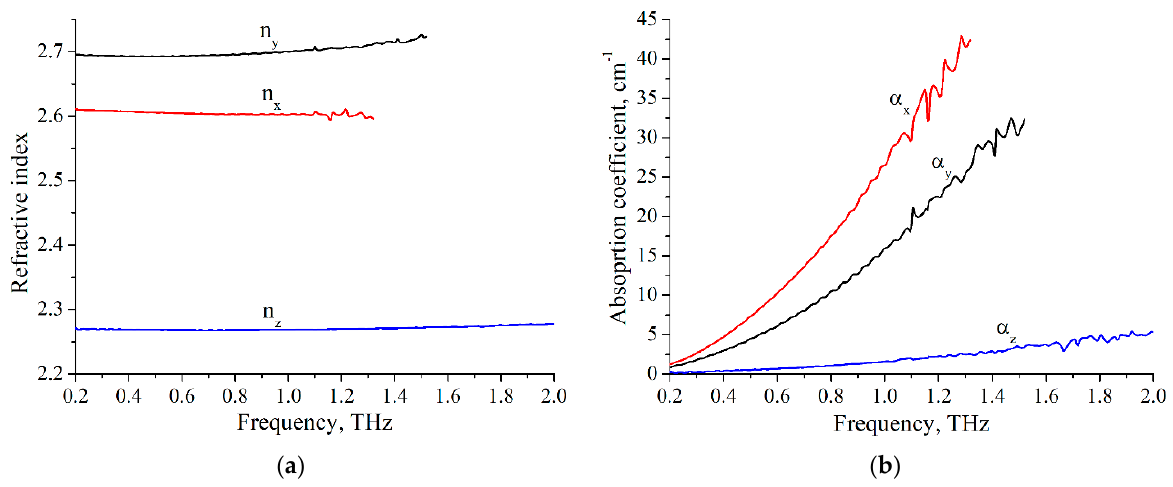
Figure 4. Terahertz optical properties of LBO crystal for three axes at room temperature: ( a ) refractive index; ( b ) absorption coefficient.